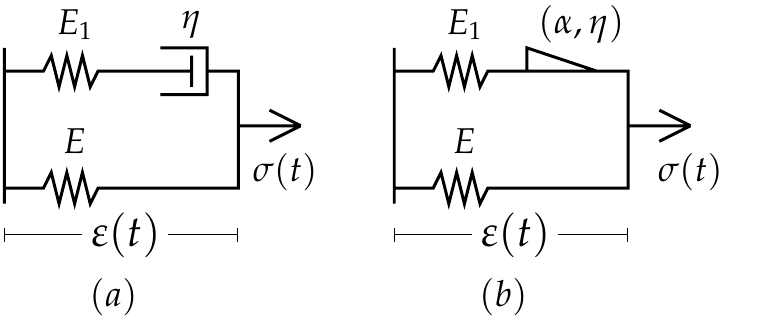
Figure 1. ( a ) Standard model or Linear Viscoelastic Solid. ( b ) The fractional version or fractional Zener